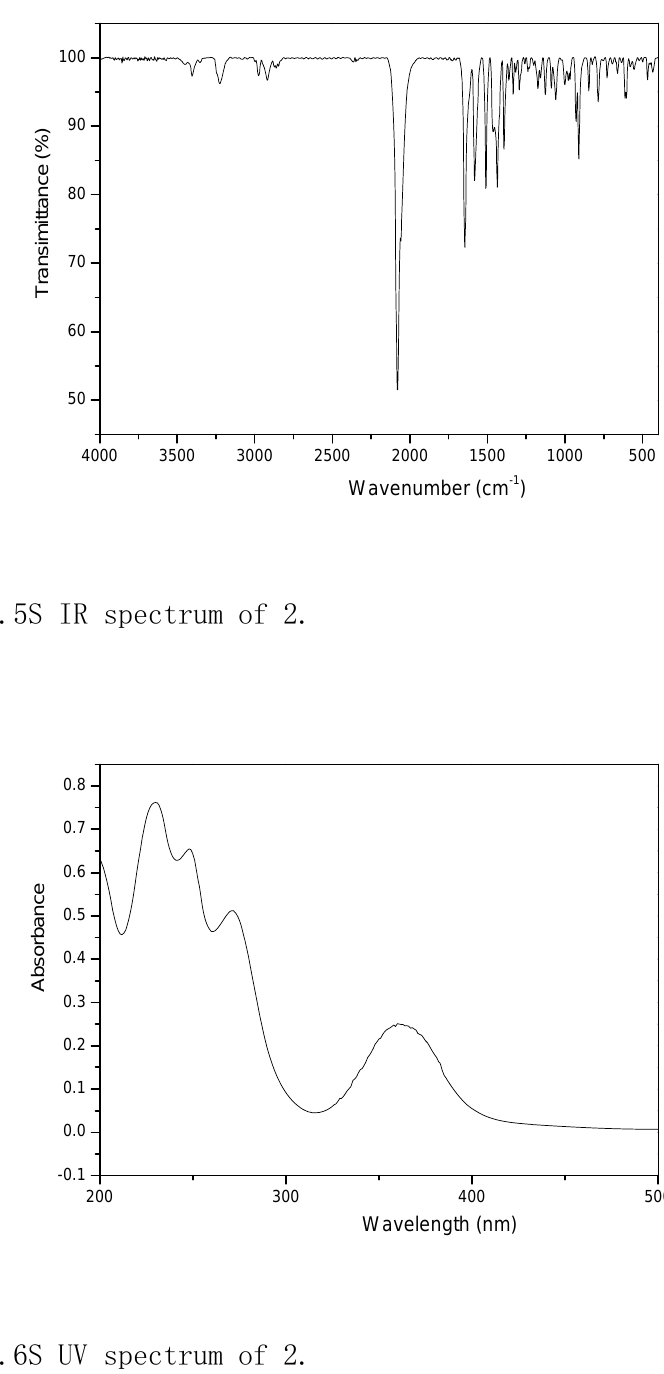
Fig.6S UV spectrum of